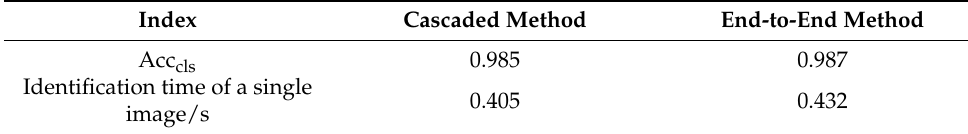
Table 4. Identification accuracies and speeds of different